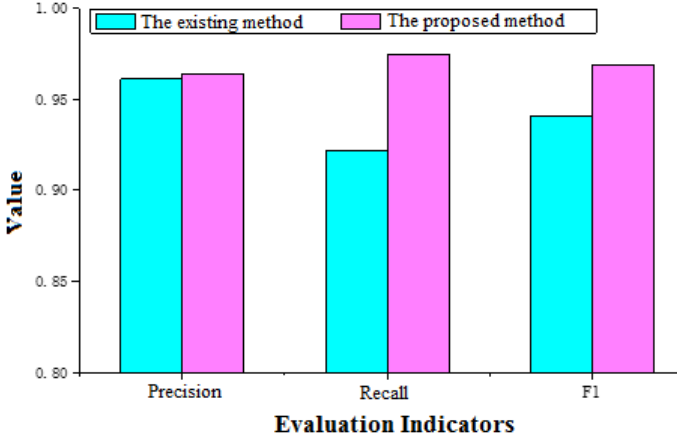
Figure 12. Overall POI matching performance.